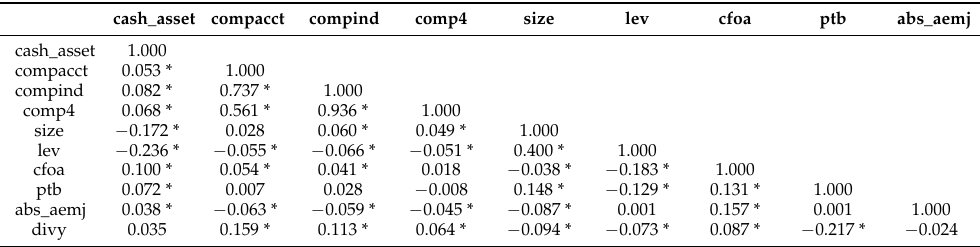
Table 2. Correlation matrix.